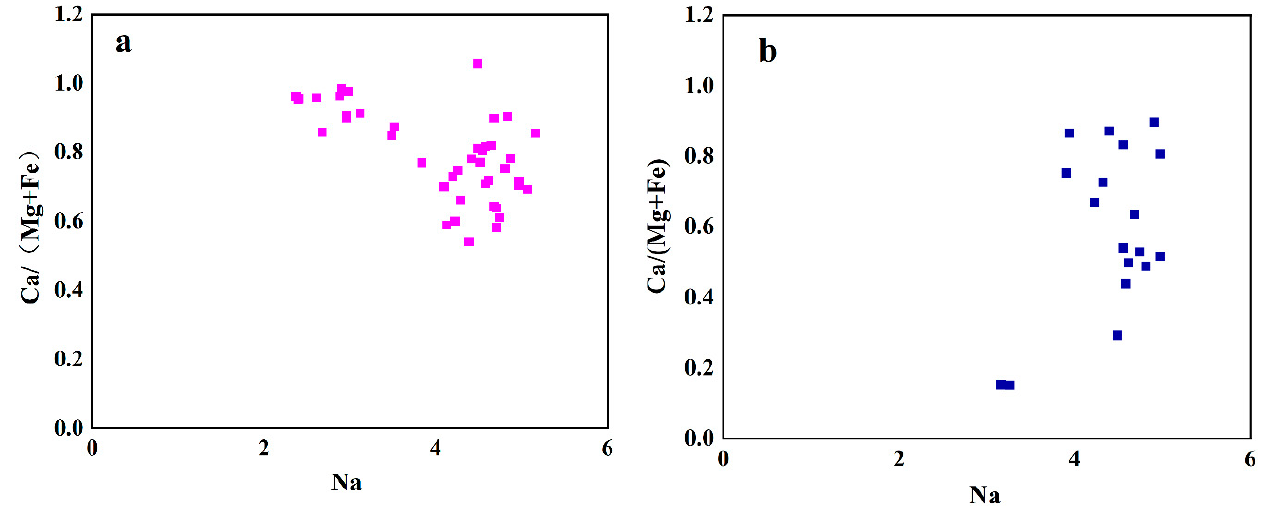
Figure 2. Discriminant diagram of Na-Ca/(Mg + Fe) in Guatemalan and Qing dynasty jadeite. ( a ) Discriminant diagram of Guatemalan jadeit; ( b ) discriminant diagram of Qing dynasty jadeite. Each element is represented by an apfu value.